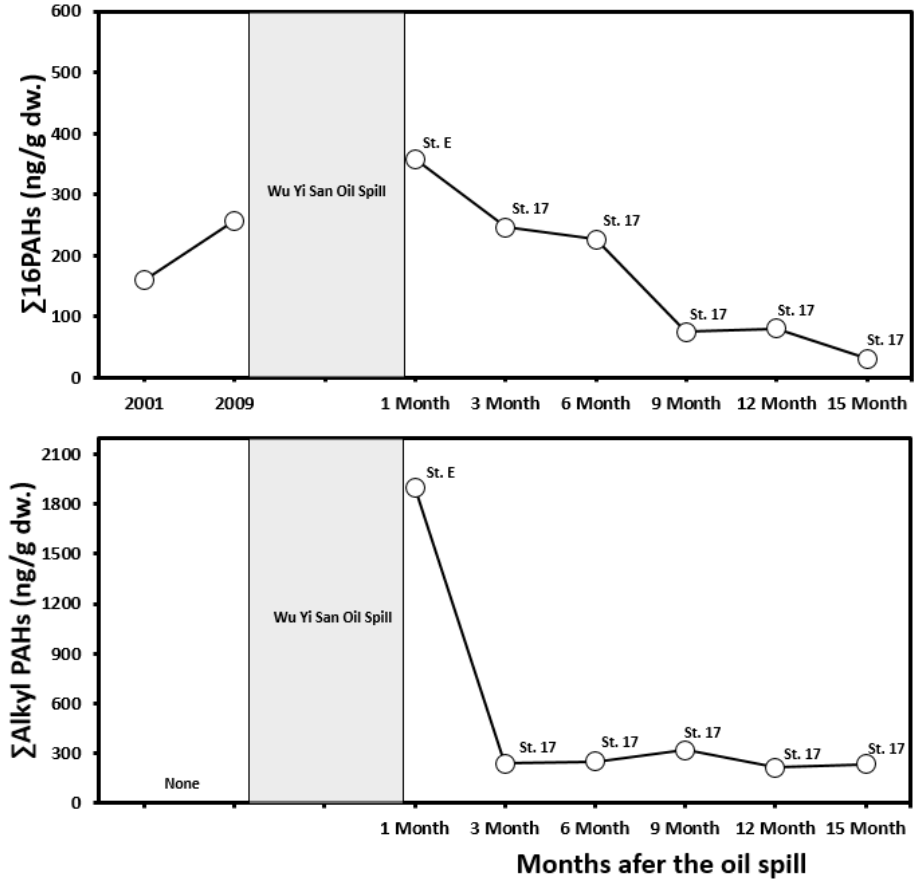
Figure 2. Variation in ∑ PAH concentrations and ∑ alkylated PAH concentrations in accident site(2001 ∑ PAHs Resi;ts [25], 2009 ∑ PAHs Resi;ts [26]). (2001 ∑ PAHs Resi;ts [25], 2009 ∑ PAHs Resi;ts